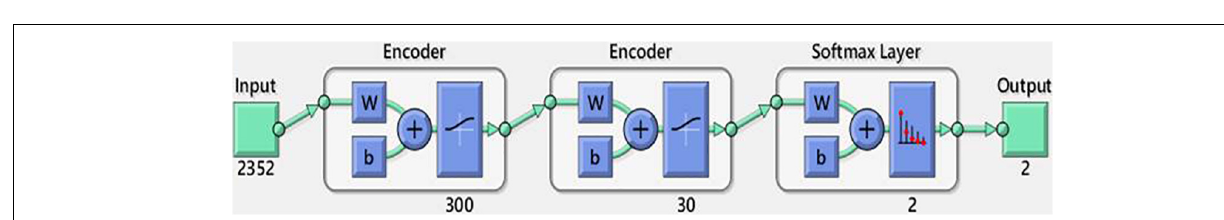
FIGURE 5 | Examples of original and reconstructed images for subjects without and with a fall risk. A two-layer AE was used, where the encoder layers had 300–30 neurons and the decoder layer had 30–300 neurons.